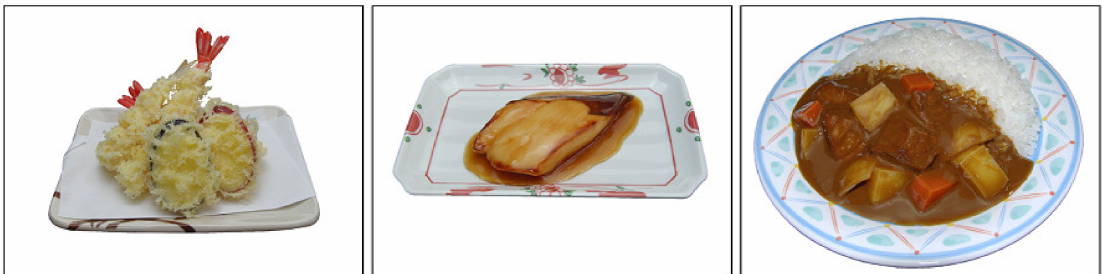
Figure 1. Examples of food